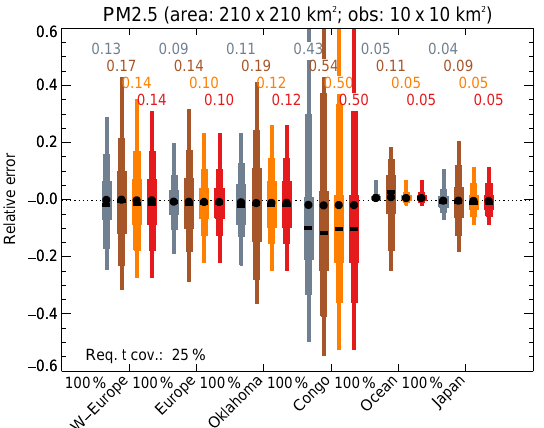
Figure 18. Monthly representation errors for an in situ ground site after collocation: purely spatial sampling (grey), no collocation (brown), area data collocated to the day of observations (bright or- ange) and area data collocated to the hour (red). Further explanation in Sect.